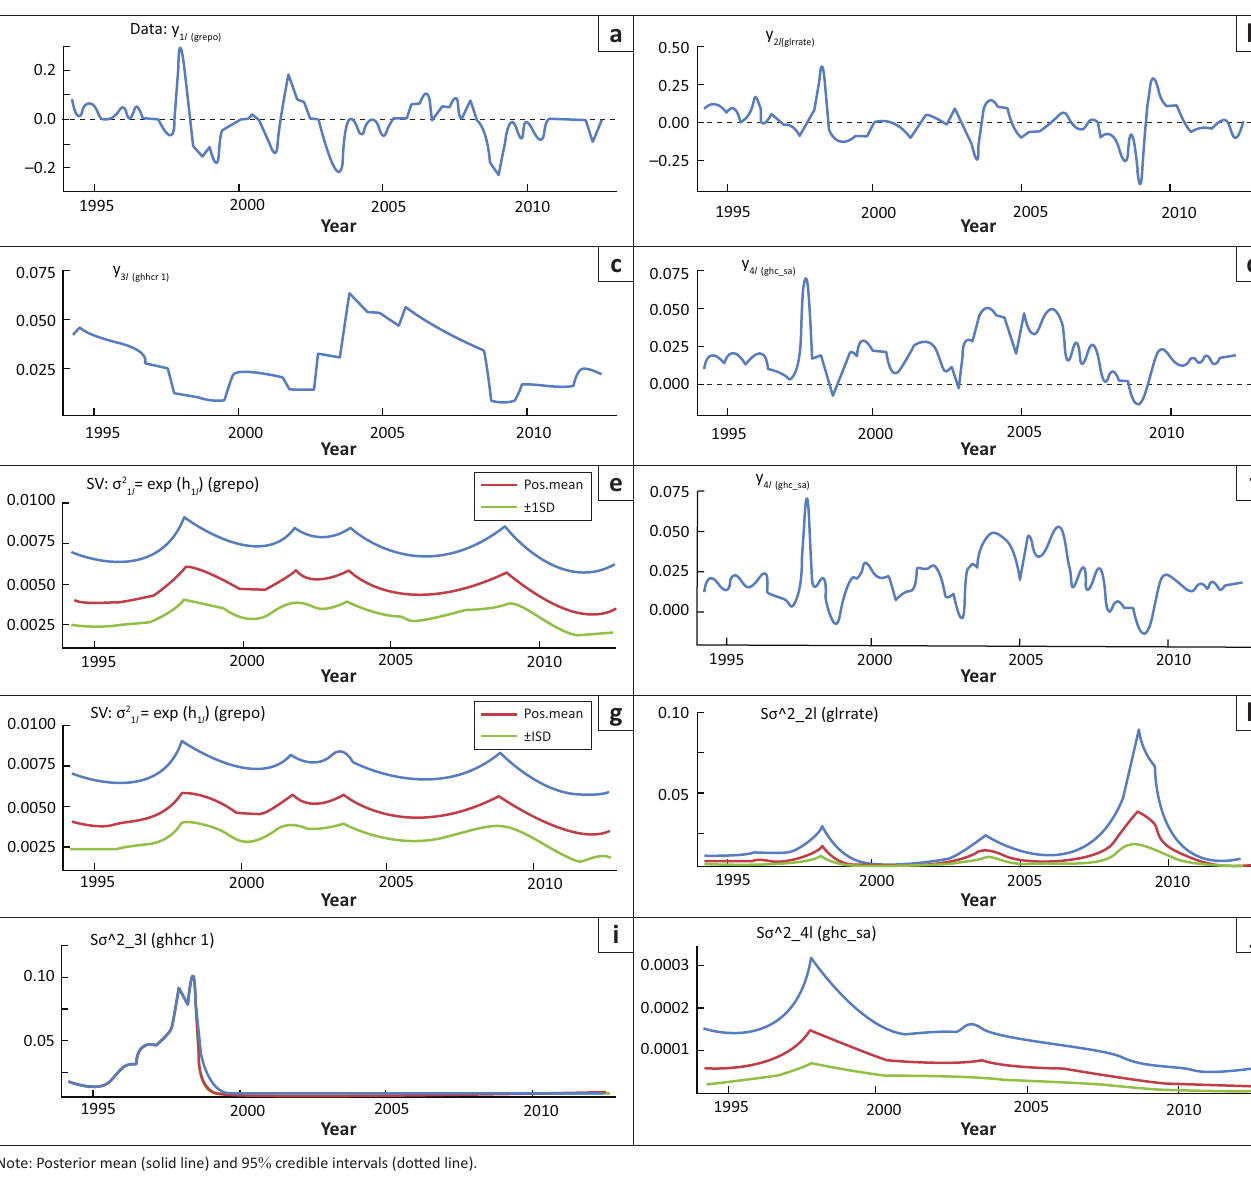
FIGURE 1: Posterior draws (a-j) for each data series and posterior mean estimates for stochastic volatility of the structural